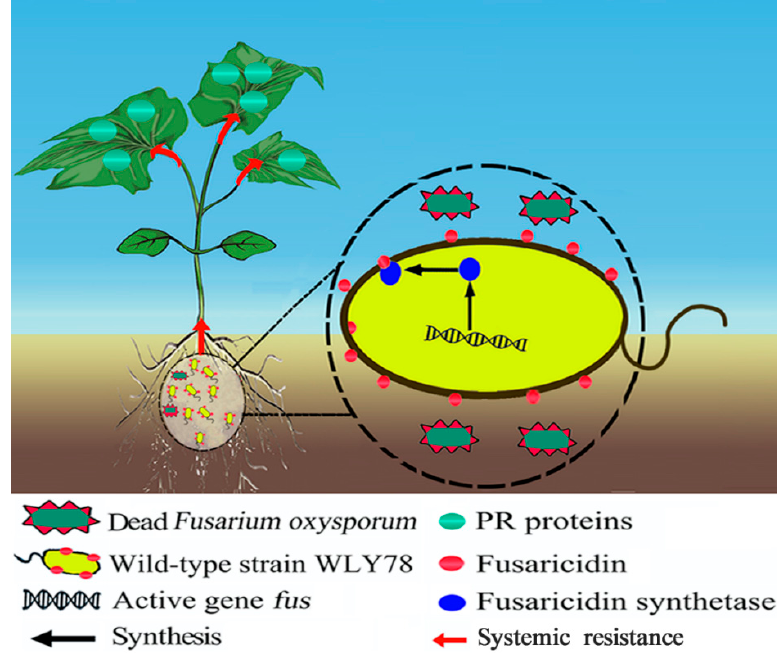
Figure 7. The proposed model of P. polymyxa WLY78 suppresses Fusarium wilt of cucumber. P. polymyxa WLY78 produces fusaricidins to inhibit F. oxysporum f. sp. cucumerium directly and elicit plant systemic resistance against Fusarium wilt of cucumber.